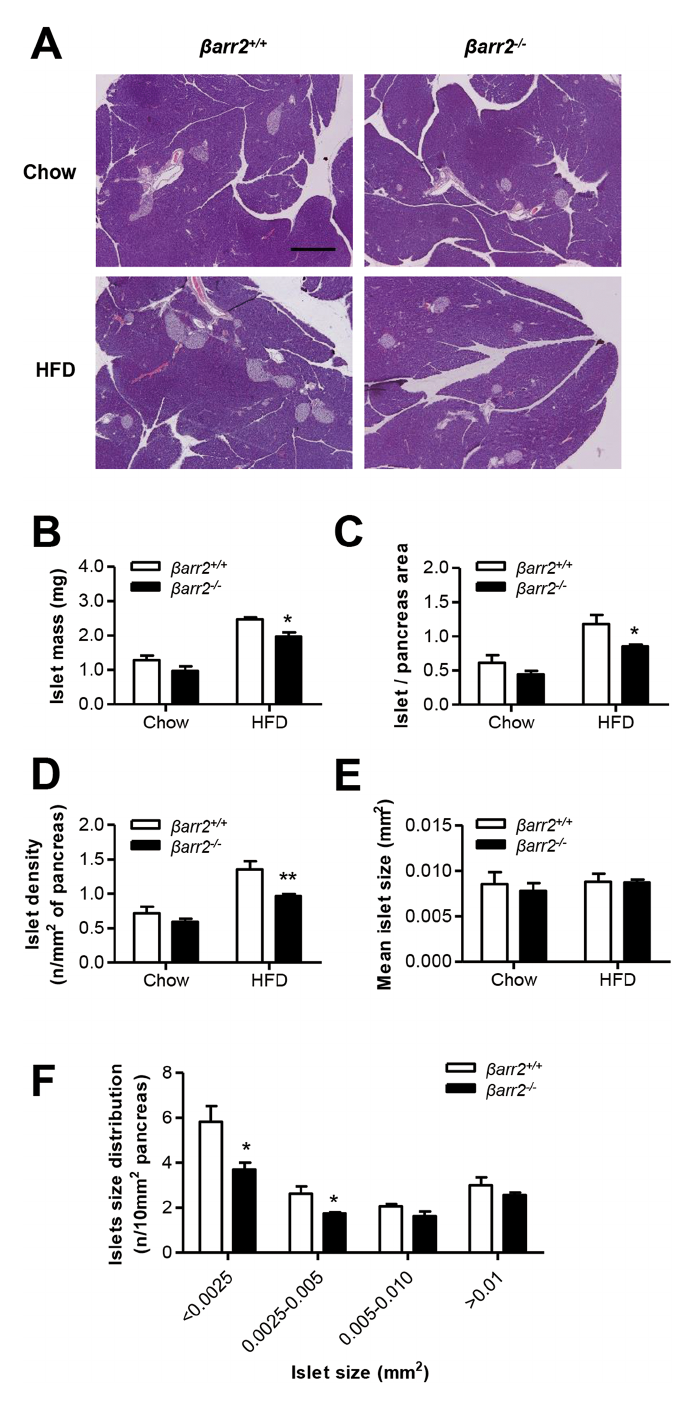
Figure 3. Quantification of islet mass in pancreas sections. (A) Pancreas sections (8–10 sections per mouse) of 16-wk-old b arr2 +/+ and b arr2 –/– mice fed a chow diet or a HFD were stained with H&E. Representative micrographs of H&E staining of pancreatic sections from b arr2 +/+ and b arr2 –/– mice. Scale bar: 500 μ m. (B) Quantification of islet mass, (C) percentage islet area relative to pancreas, (D) islet density, (E) mean islet size and (F) islet size distribution of b arr2 +/+ and b arr2 –/– mice fed with a HFD (n = 3–5). * P < 0.05, ** P < 0.01, versus b arr2 +/+